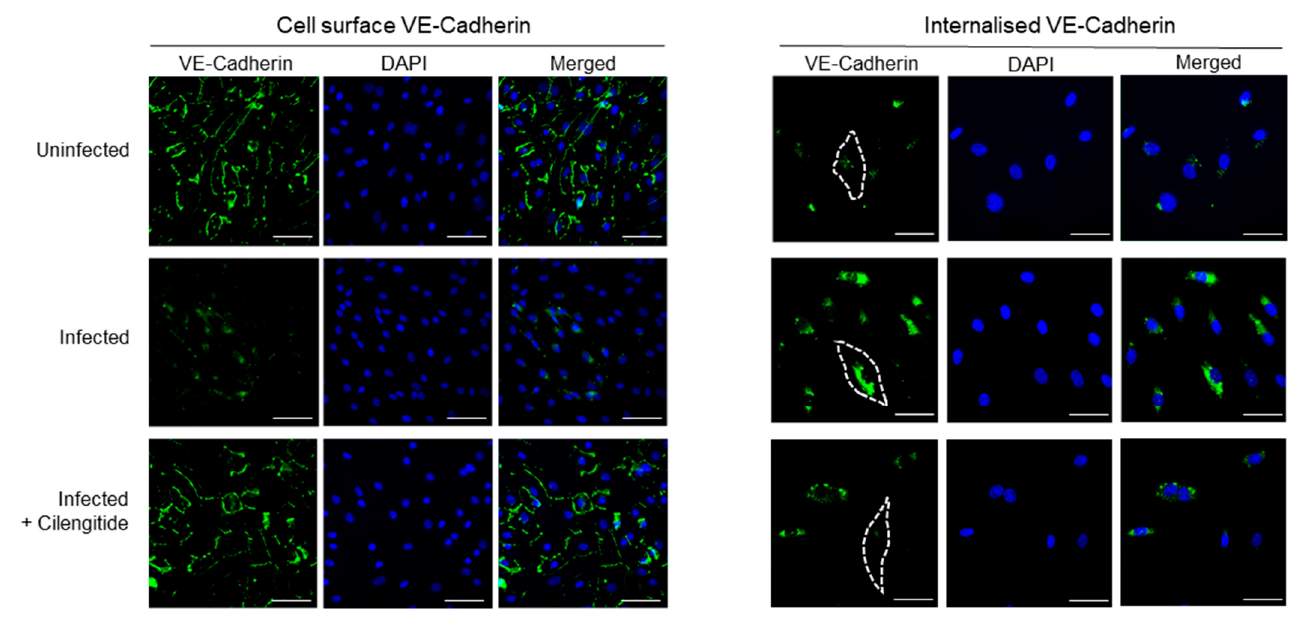
Figure 2. Vascular-Endothelial Cadherin is targeted by RGD site of SARS-CoV-2 spike protein to drive vascular dysfunction. Immunofluorescence images of a confluent human endothelial cell monolayer stained with VE-Cadherin and DAPI, measured for either cell-surface or internal VE- Cadherin. Dotted lines represent the endothelial cell border as visualized using DIC. Scale bars represent 10 µ m.